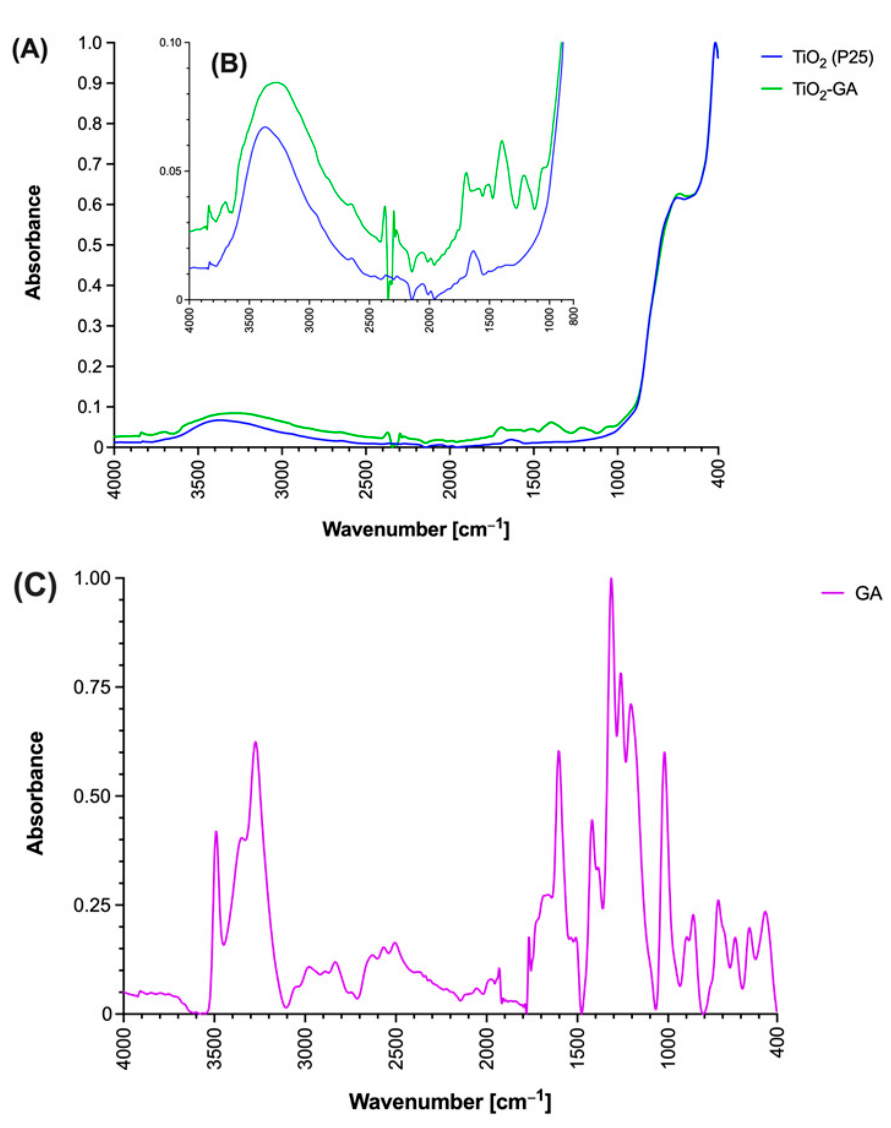
Figure 5. ATR-FTIR spectra TiO 2 , TiO 2 -GA and gallic acid. ( A ) Full spectrum in the range of 4000–400 cm − 1 , ( B ) inset of the 4000–800 cm − 1 range with relative absorbance below 0.1. ( C ) Spectrum of gallic acid in the range of 4000–400 cm − 1 .